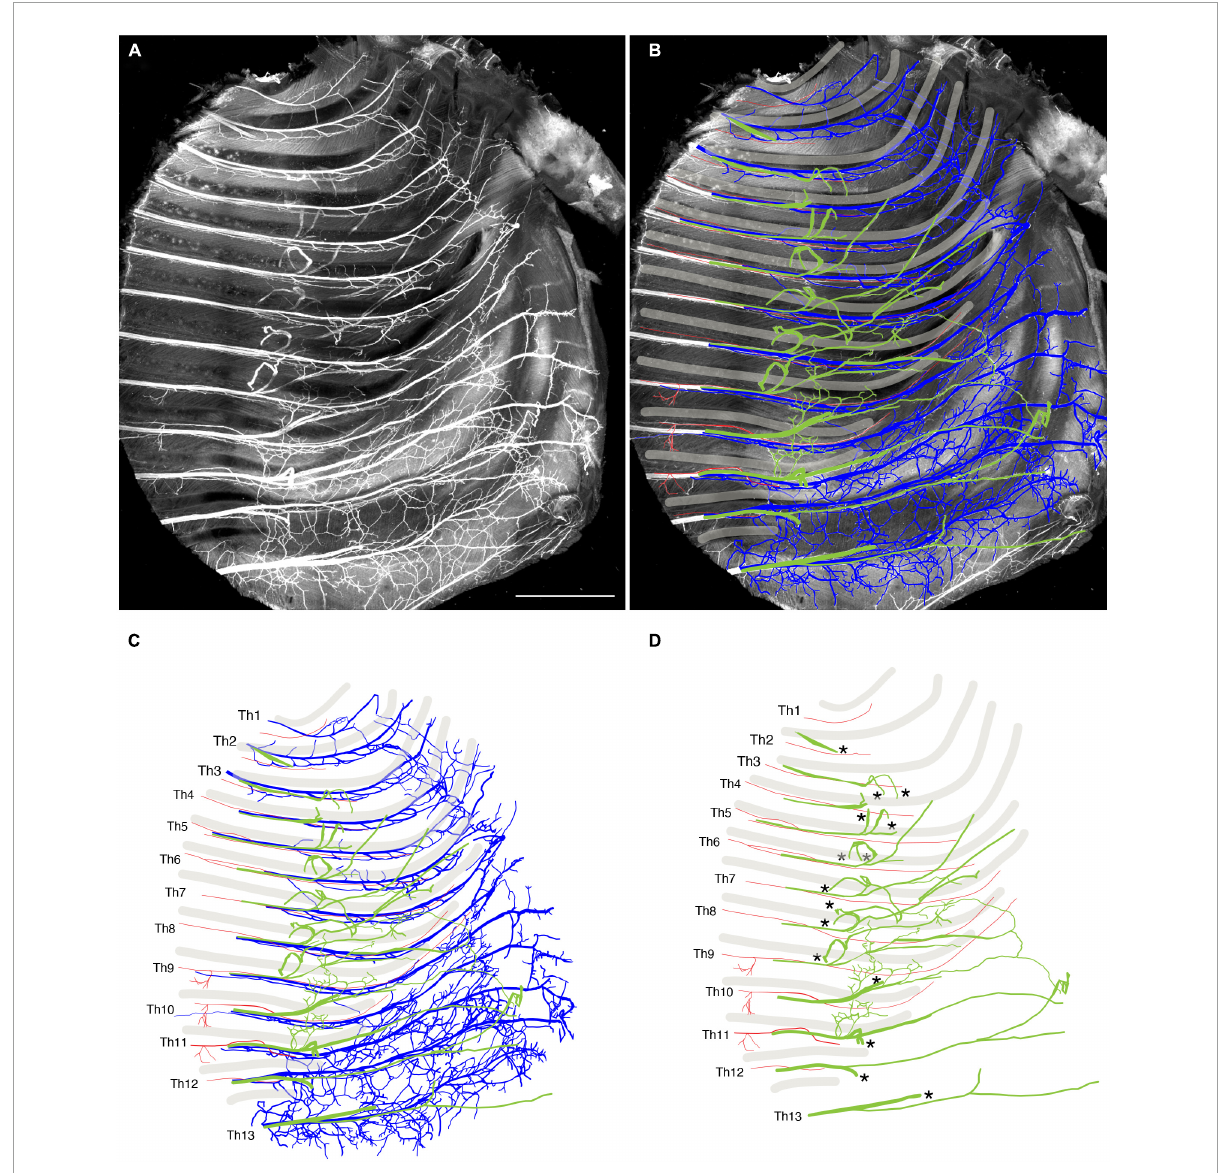
FIGURE5 Close-up view of the thoracic wall from an E15 embryo. The anterior side is toward the top of the micrographs. The costal side is toward the right of the micrographs. The cartilaginous costae are indicated by gray bars. (A) Black and white MIP image. (B,C) The superficial branches (red) run along the lower margin of the costae while the deep (blue) and lateral cutaneous (green) branches change their courses toward one or more of the above intercostal spaces. (D) The superficial and lateral cutaneous branches are extracted for comparison, showing the segmental and non-meristic innervation patterns of the superficial and lateral cutaneous branches, respectively. Asterisks are stumps of the dermal branches of the lateral cutaneous branch, because the skin and dermis were removed for transparency.